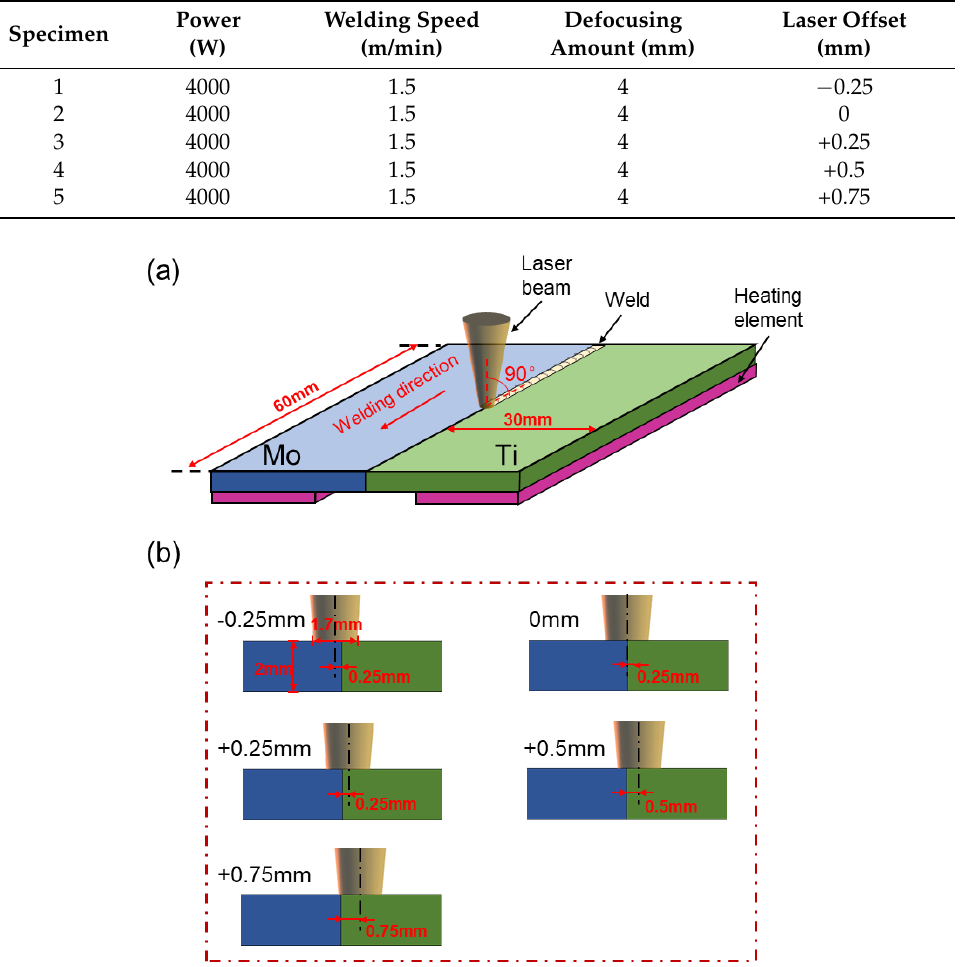
Figure 2. The schematic illustration of ( a ) laser beam offset welding and ( b ) spot size and position at different offsets.